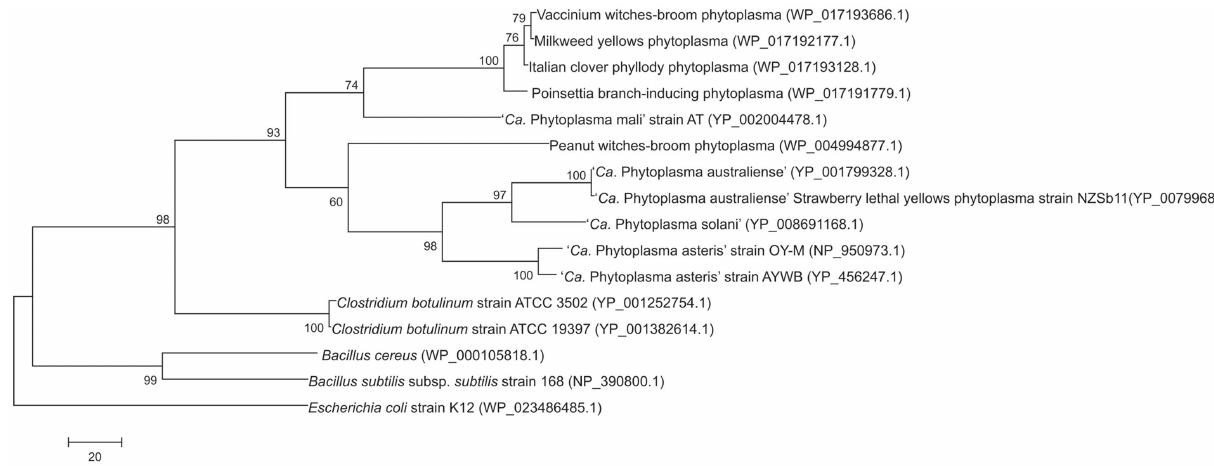
Figure 4. Phylogenetic tree constructed by parsimony analyses of deduced malate dehydrogenase peptide sequences of available phytoplasmas, Clostridiumbotulinum strains ATCC3502 and ATCC19397, Bacillussubtilis subsp. subtilis , and Bacilluscereus employing Escherichiacoli strain K12 as outgroup. Accession numbers are given in parentheses. Numbers on the branches are bootstrap values obtained for 1,000 replicates (only values above 60% are shown). The tree is drawn to scale, with branch lengths calculated using the average pathway method, and are in the units of the number of changes over the whole sequence. The scale bar represents 20 amino acid substitutions.